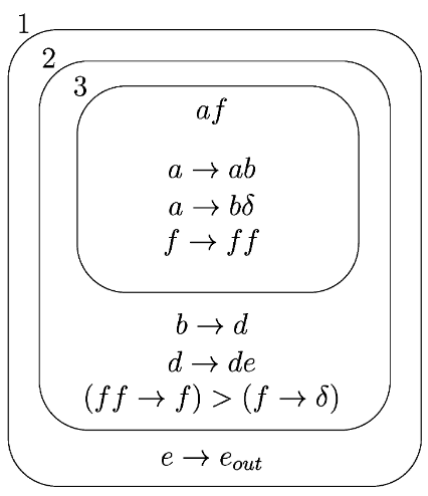
Figure 3. Example initial configuration